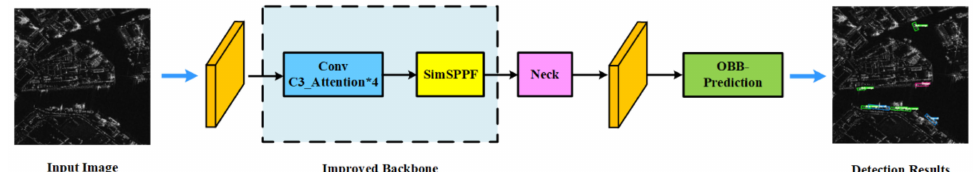
Figure 1. The overall framework of the proposed lightweight